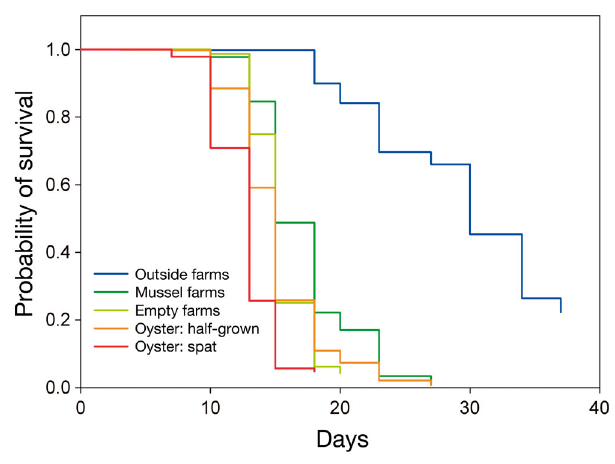
Fig. 2. Survival of sentinel oysters Crassostrea gigas according to farming practices in the Thau